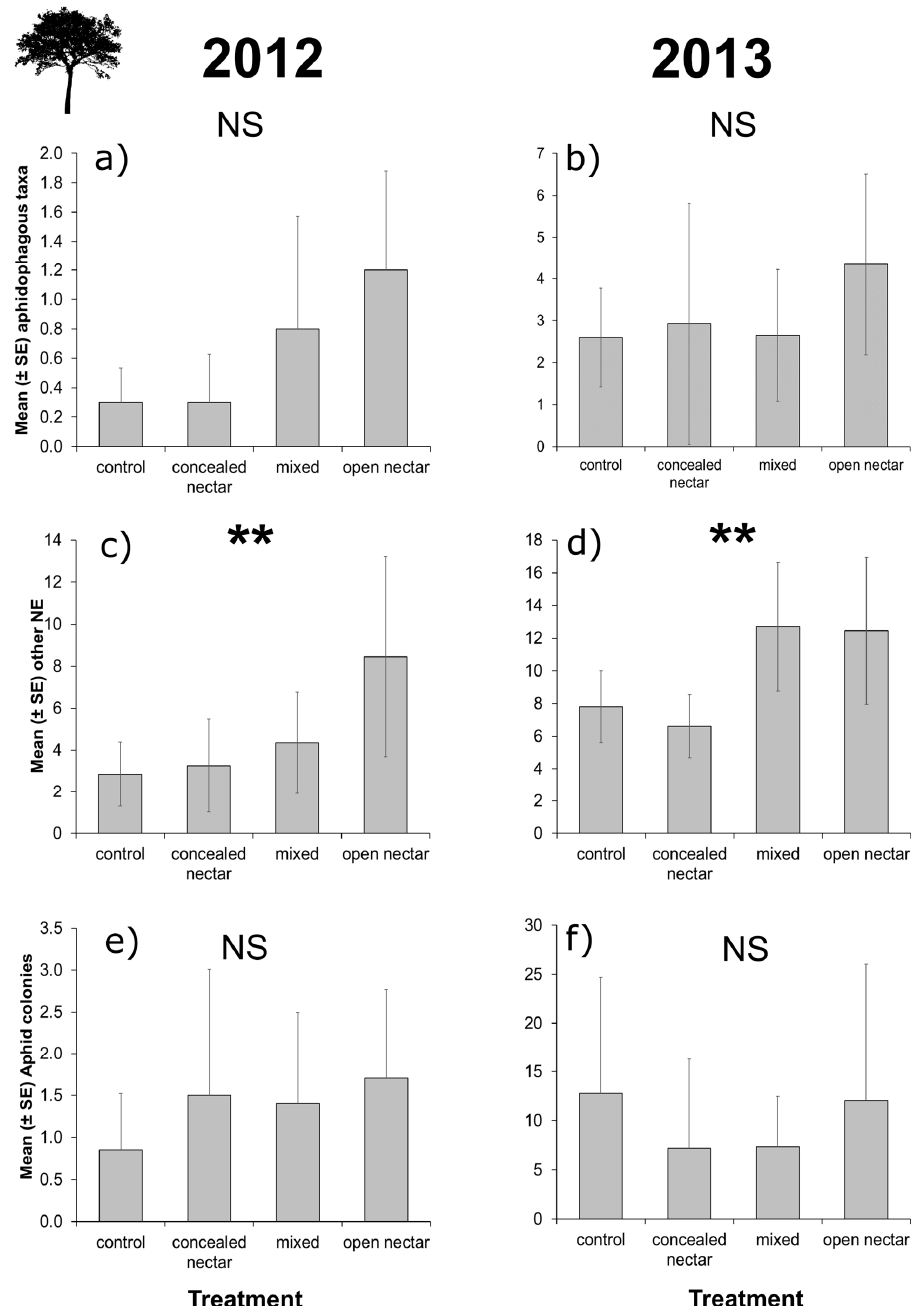
Figure 3. Effects of flower strips on natural enemies and aphid pests in apple trees (number of individuals/colonies per fifty branches). We detected no effect of treatment (control, concealed-nectar, mixed, and open-nectar) on aphidophagous natural enemies (hoverflies, lacewings, earwigs and ladybirds; ( a , b )) or pest aphid densities in either year ( e , f ); but significant effects of treatment on other natural enemy abundance (non-syrphid flies, parasitoid wasps, bugs and non-coccinellid beetles; ( c , d )). Error bars show standard errors and asterisks show level of significance (NS = p > 0.05, * = p < 0.05, ** = p < 0.01, *** = p < 0.001) reported in LRTs (see Table 2 and main text for details).